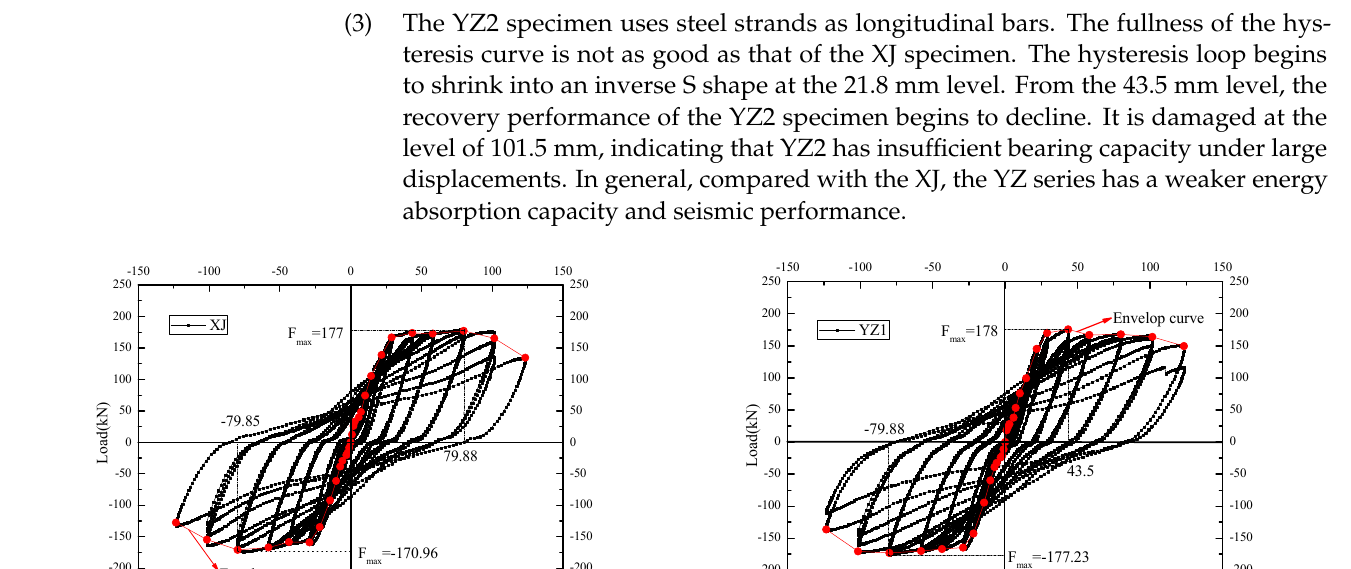
(3) The YZ2 specimen uses steel strands as longitudinal bars. The fullness of the hys- teresis curve is not as good as that of the XJ specimen. The hysteresis loop begins to shrink into an inverse S shape at the 21.8 mm level. From the 43.5 mm level, the recovery performance of the YZ2 specimen begins to decline. It is damaged at the level of 101.5 mm, indicating that YZ2 has insufficient bearing capacity under large displacements. In general, compared with the XJ, the YZ series has a weaker energy absorption capacity and seismic performance.